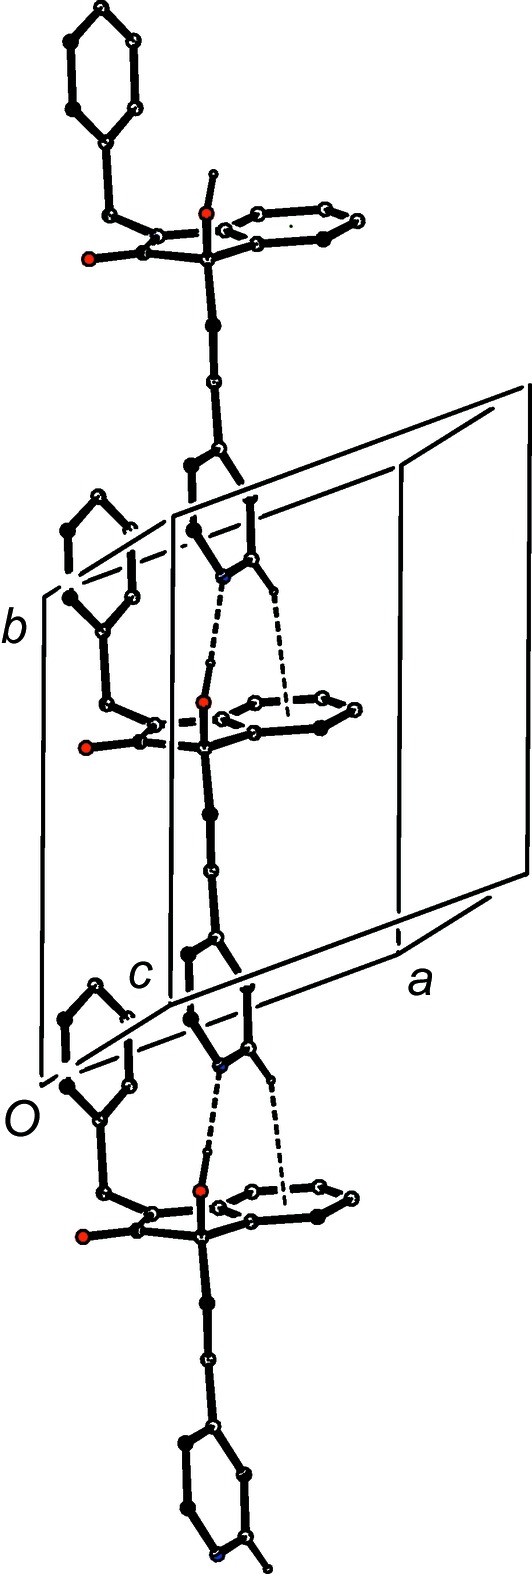
Part of the crystal structure of com­pound (Ie), showing the formation of a chain of rings running parallel to the [010] direction and built from O—H⋯N and C—H⋯π(arene) hydrogen bonds. Hydrogen bonds are drawn as dashed lines and, for the sake of clarity, H atoms not involved in the motifs shown have been omitted.